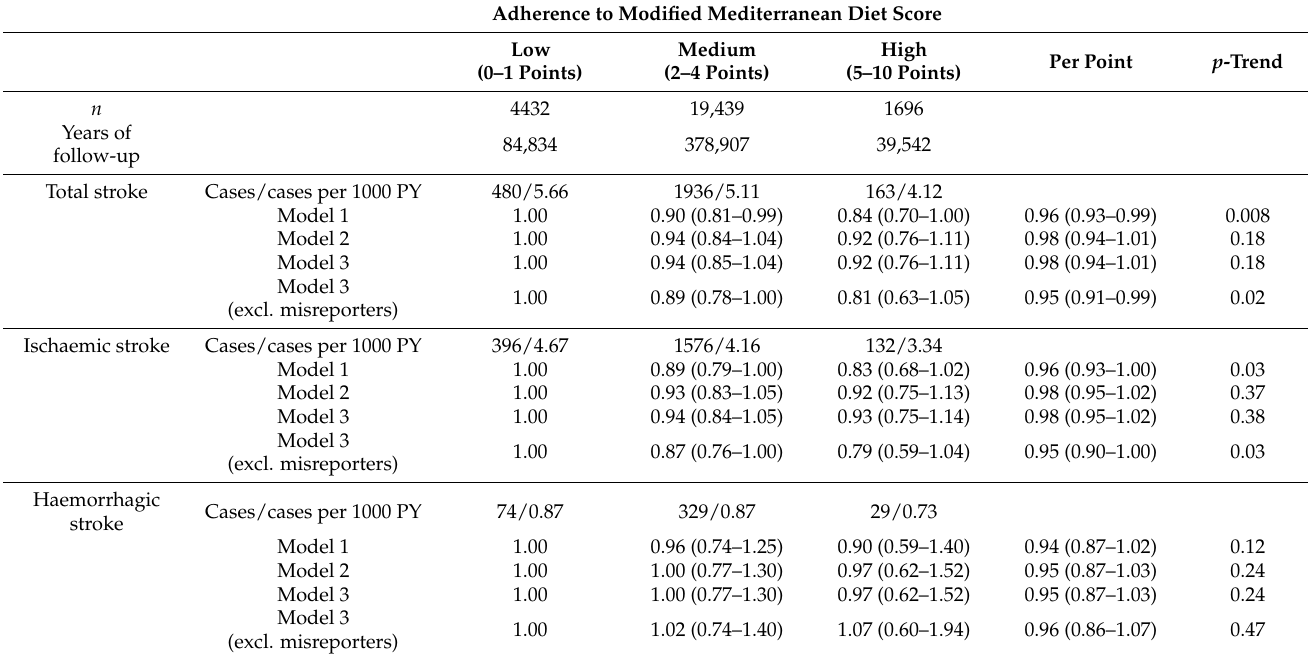
Table 4. Association (HR and 95% CI) between modified Mediterranean diet score and risk of